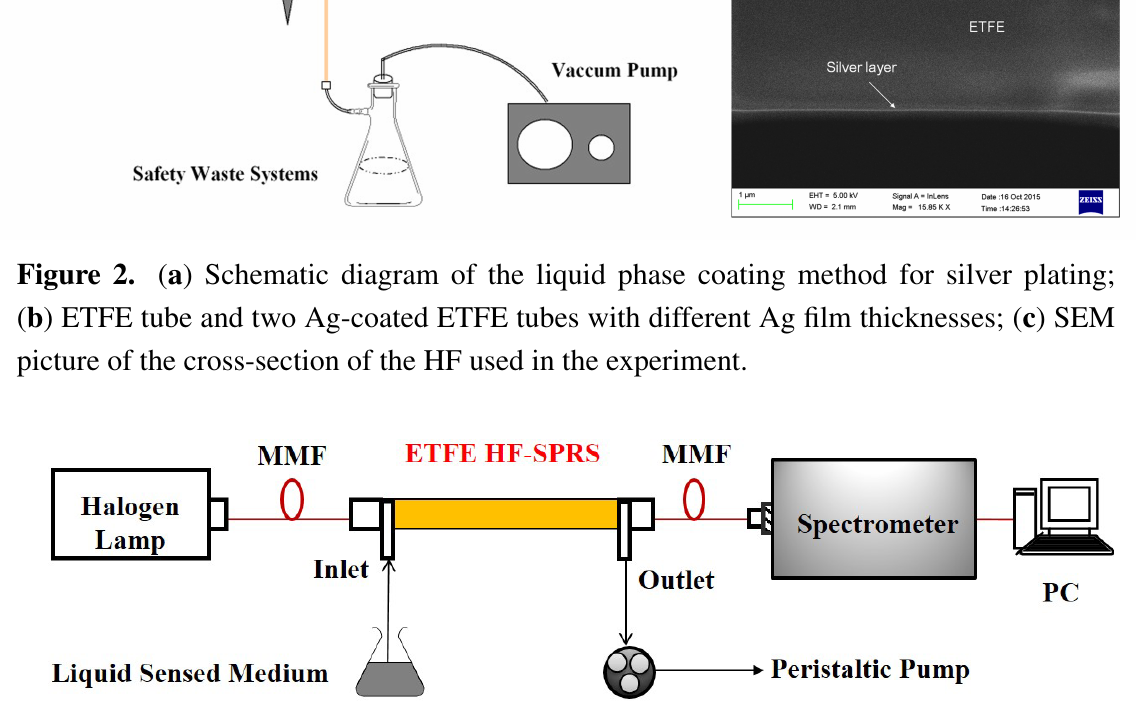
Figure 3. Diagram of the experimental